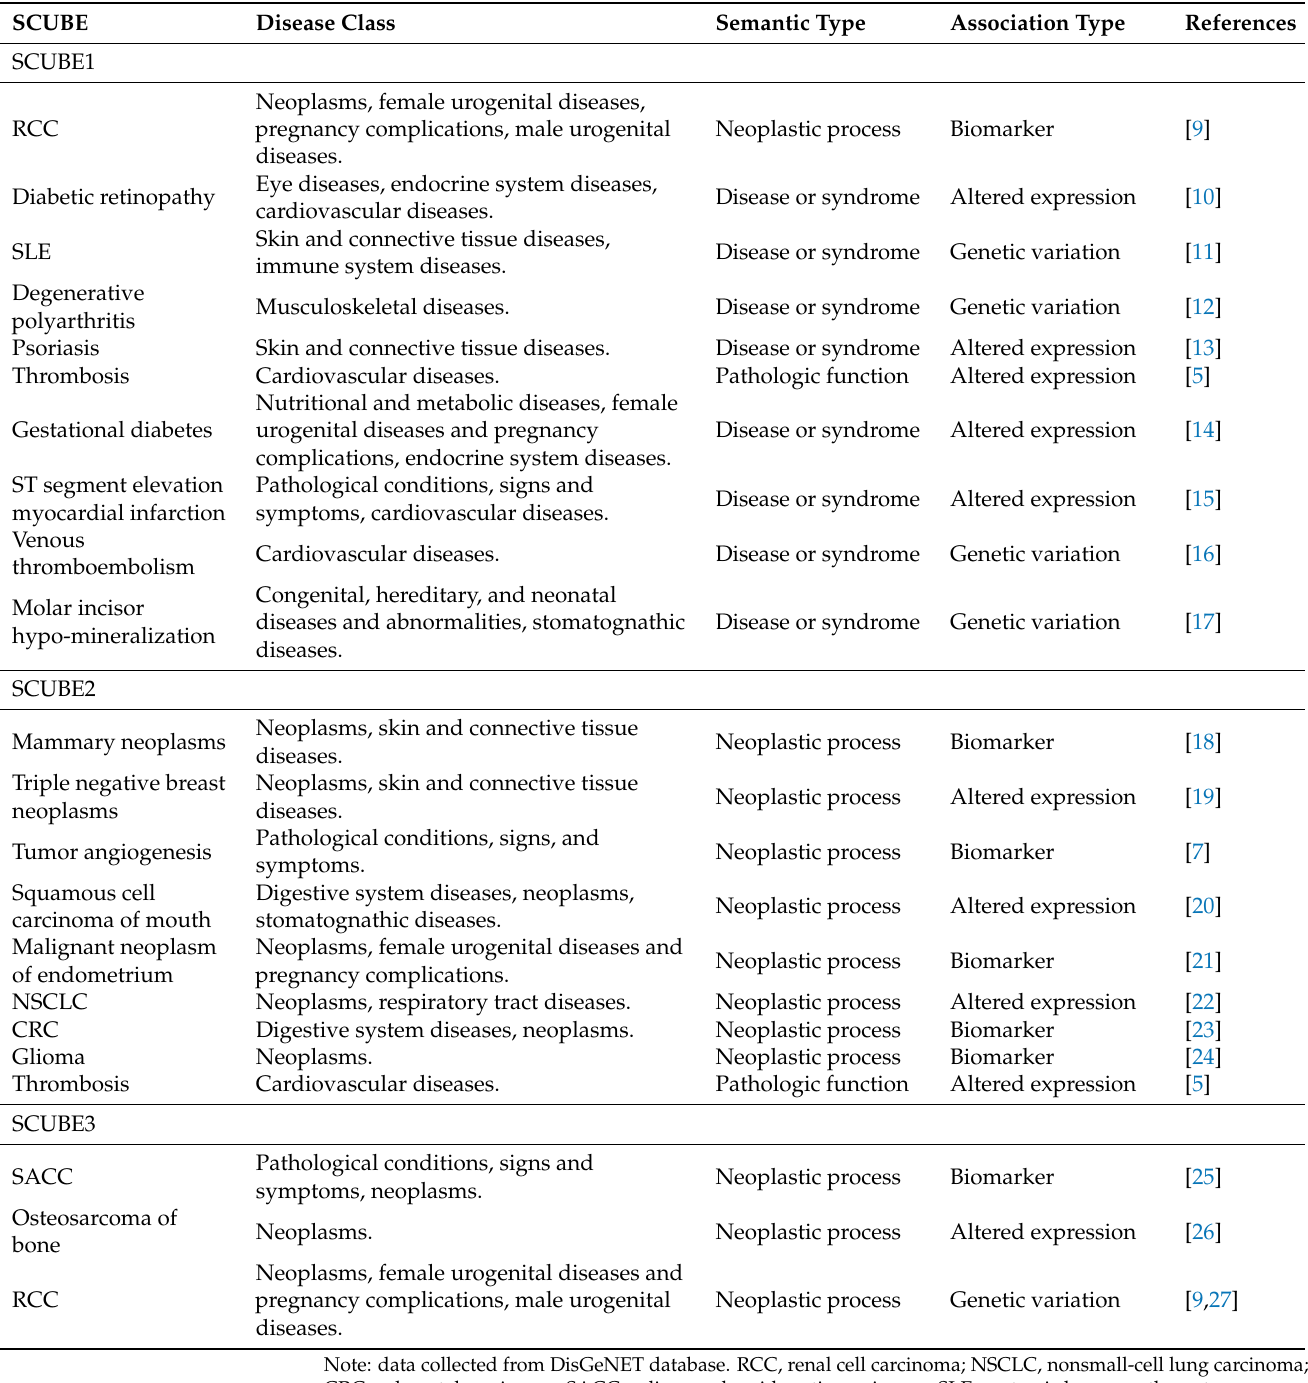
Table 1. SCUBE family disease